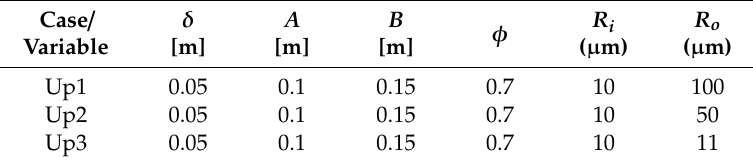
Figure 3. Principal sketch of the geometry (to the left) and flow patterns used in the modelling (to the right) of Up-flow SPB storage. Table 2. Values of parameters used in a case study of Up-flow